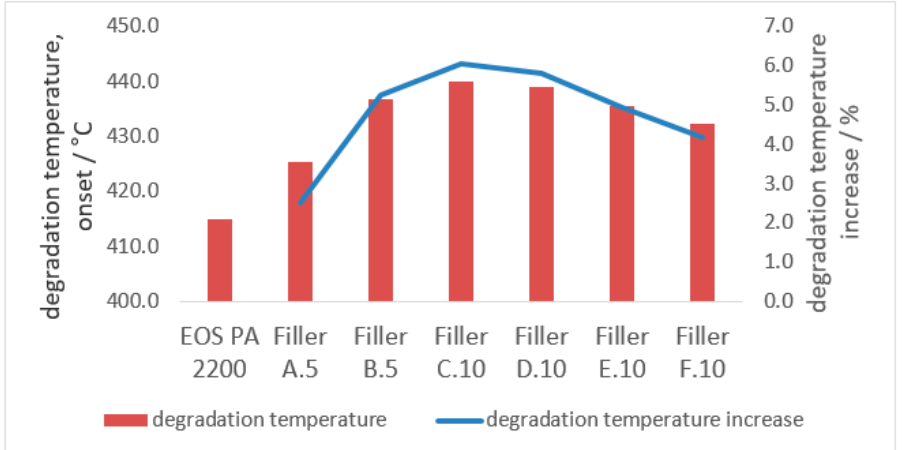
Figure 5. Thermogravimetric analysis–degradation temperature comparison.